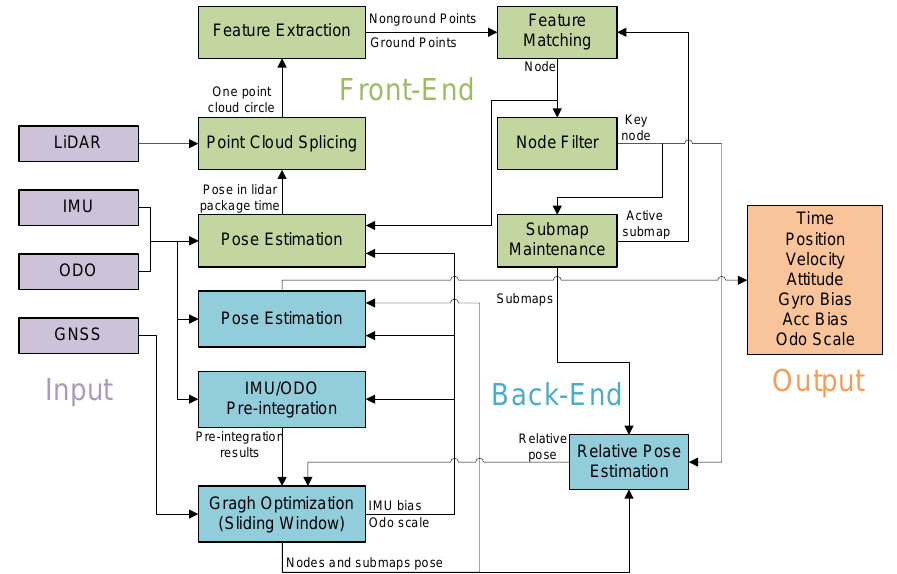
Figure 2. System overview of the GNSS (global navigation satellite system) / IMU (inertial measurement unit) / odometer (ODO) / LiDAR (light detection and ranging)-SLAM (simultaneous localization and mapping) integrated navigation system.